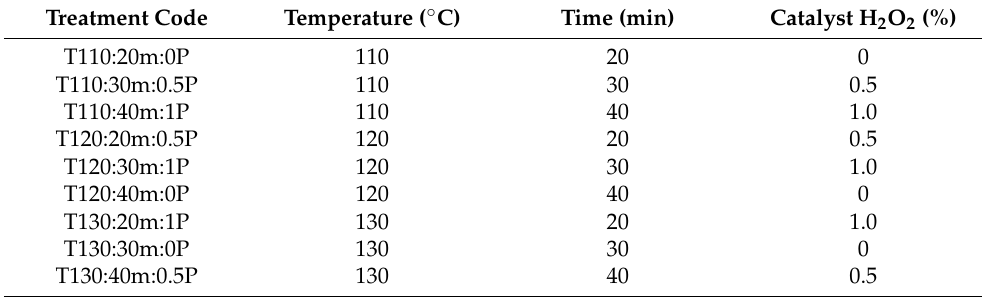
Table 3. Proposal Taguchi design for the increase of furans and phenolic